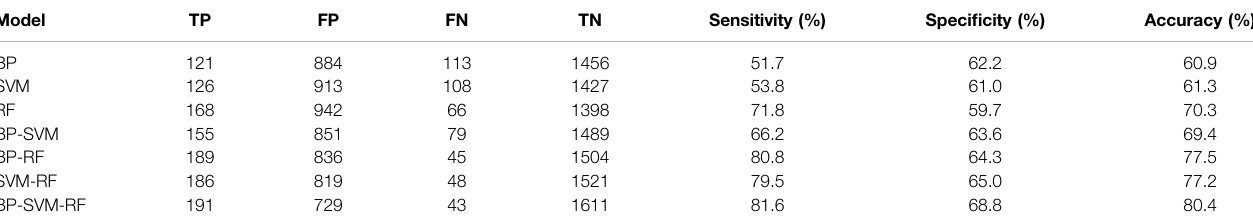
TABLE 4 | Confusion matrix for classi fi cation results of different